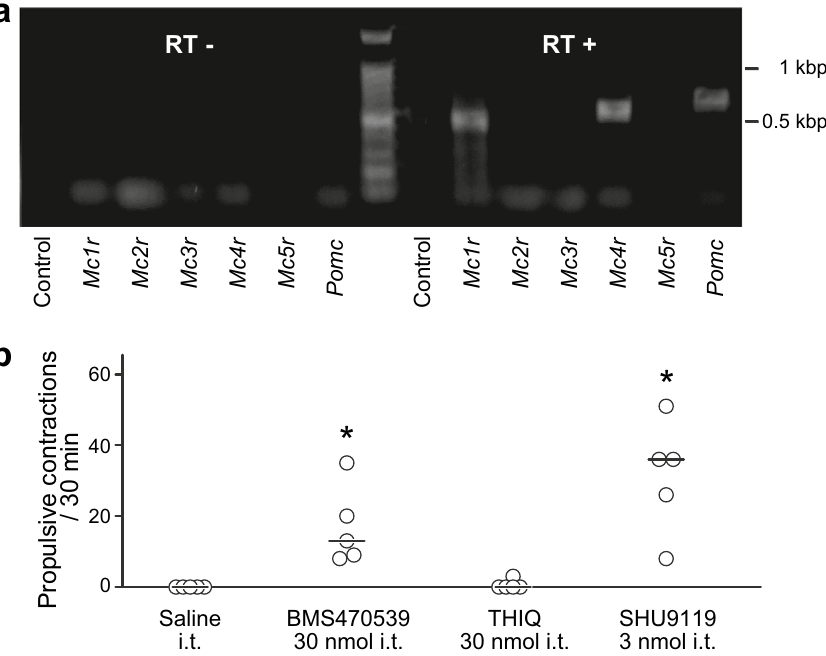
Figure 5. Subtypes of MCR responsible for the α-MSH effect. ( a ) Single-stranded cDNA was generated from total RNA isolated from L6-S1 spinal cord tissue using reverse transcriptase (RT +) and amplified using PCR with primer pairs specific for rat Mc1r - Mc5r and Pomc . Amplified products of Mc1r , Mc4r and Pomc were observed in appropriate sizes. The reactions without reverse transcriptase (RT-) were analysed with PCR as a negative control. ( b ) Summarised graph of number of propulsive contractions during a period of 30 min after i.t. of saline, BMS470539 (MC1R agonist, 30 nmol), THIQ (MC4R agonist, 30 nmol) and SHU9119 (MC1R agonist and MC4R antagonist, 3 nmol). BMS470539 and SHU9119, but not THIQ, significantly increased the number of propulsive contractions compared to that in the saline group. Each open circle ( ○ ) indicates a result from an individual rat, and the black bar shows the median. *Denotes a significant difference from the saline group ( P < 0.05). Five rats were used in each